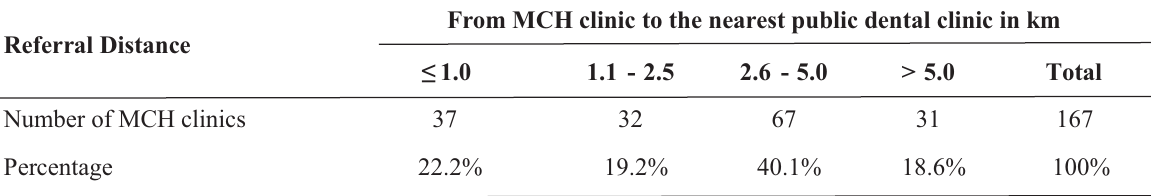
Table 2: The average, minimum and maximum referral distance in each MOH area MOH area